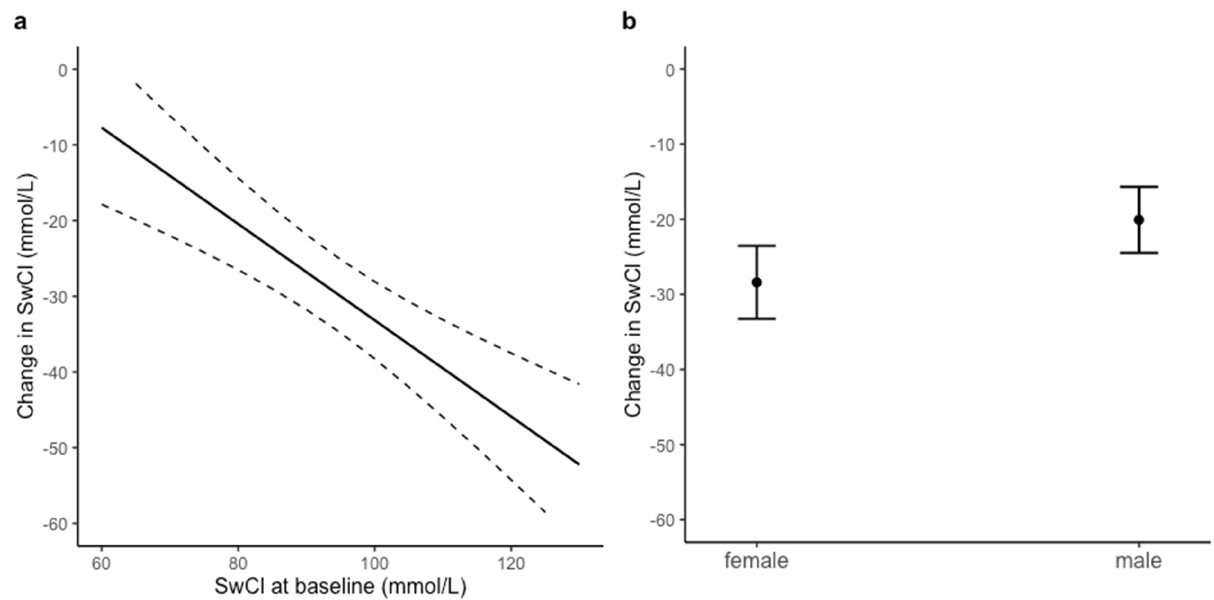
Figure 3. Association of change in SwCl six months after LUM/IVA with SwCl at baseline ( a ) and the difference in SwCl